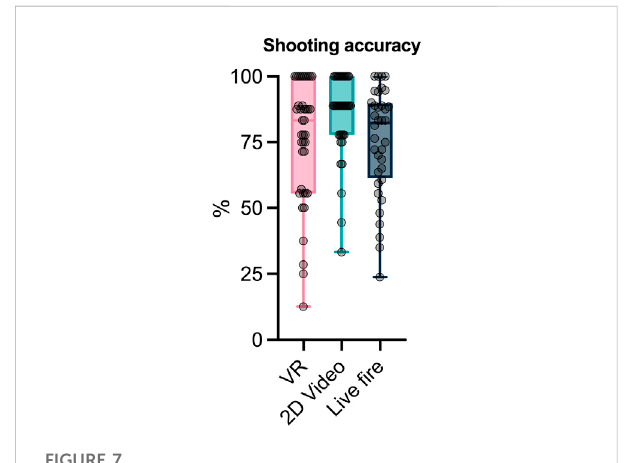
FIGURE 7 Box and whisker plot for shooting accuracy